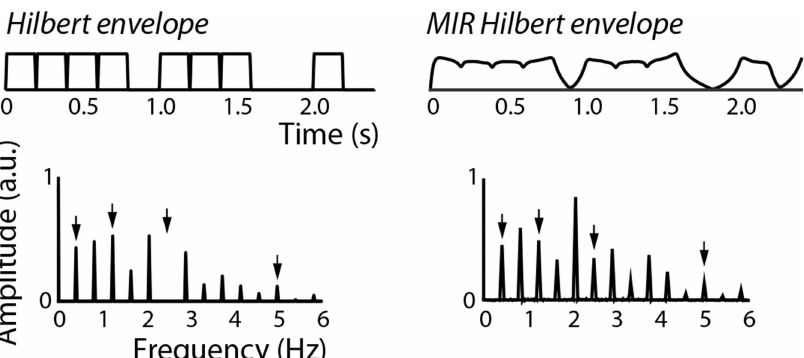
Fig 3. Comparison of envelopes (top) and stimulus spectra(bottom) obtained by using Matlab’s Hilbert function (left) or the MIR-implemented Hilbert transform, shown here for “Pattern 3” (from [44]). Since the MIR toolbox makes use of time-domain filtering, envelopes are smooth and frequency spectra differ from those obtained from the Matlab Hilbert transform. The most obviousdiscrepancy is at 2.5 Hz, where there is no energy in the spectrum obtainedusing the Matlab Hilbert